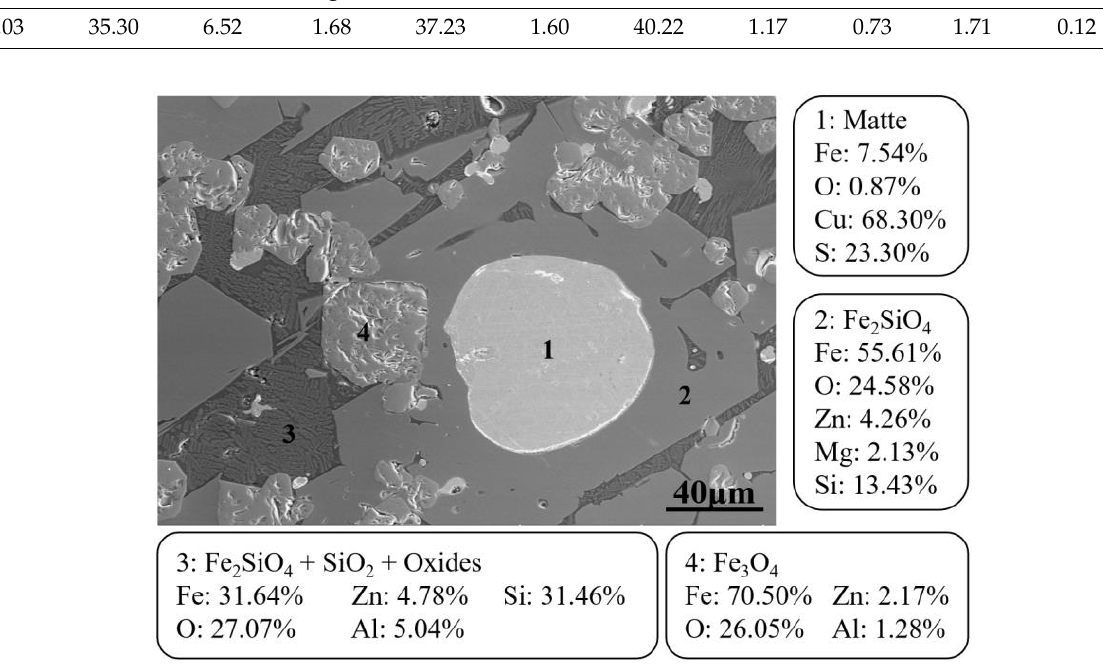
Figure 1. Electron microscopy and EDS results of copper slag (wt.%). Table 1. The composition of copper slag.